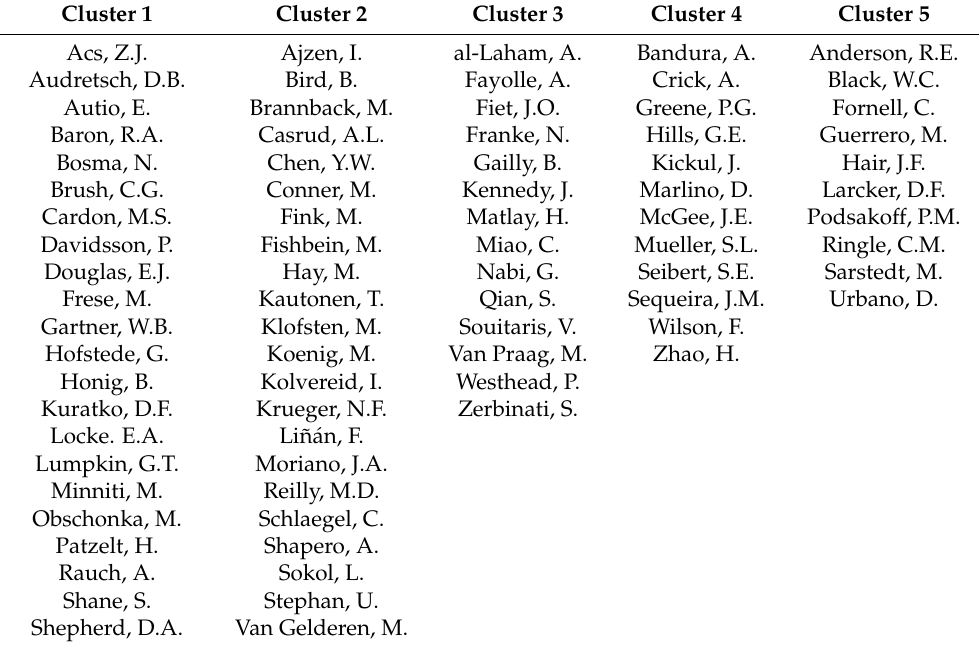
Table A1. Authors—Clusters related to EI as a keyword (SCOPUS